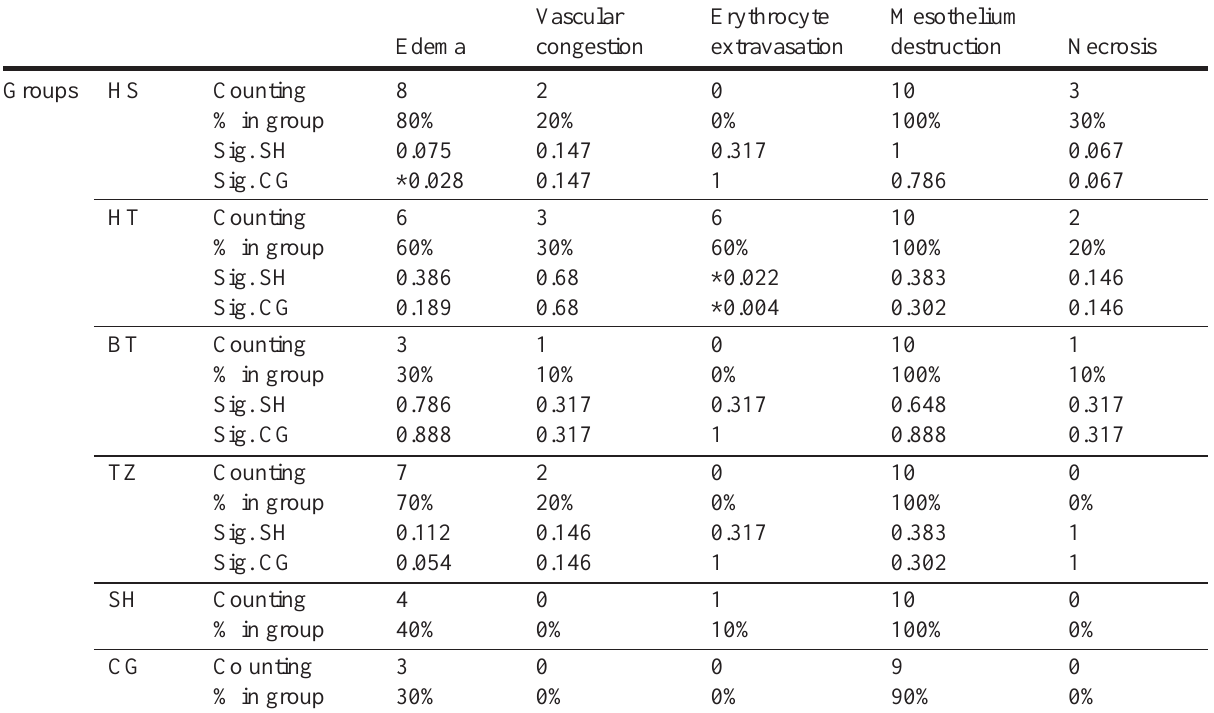
TABLE 3 - Percentage and counting of histopathologic alterations distributed per group of animals and statistical significance between groups HS (heat shock), HT (high temperature), BT (body temperature) and TZ (temperature zero degree) and groups SH (sham) and CG (control group) Vascular